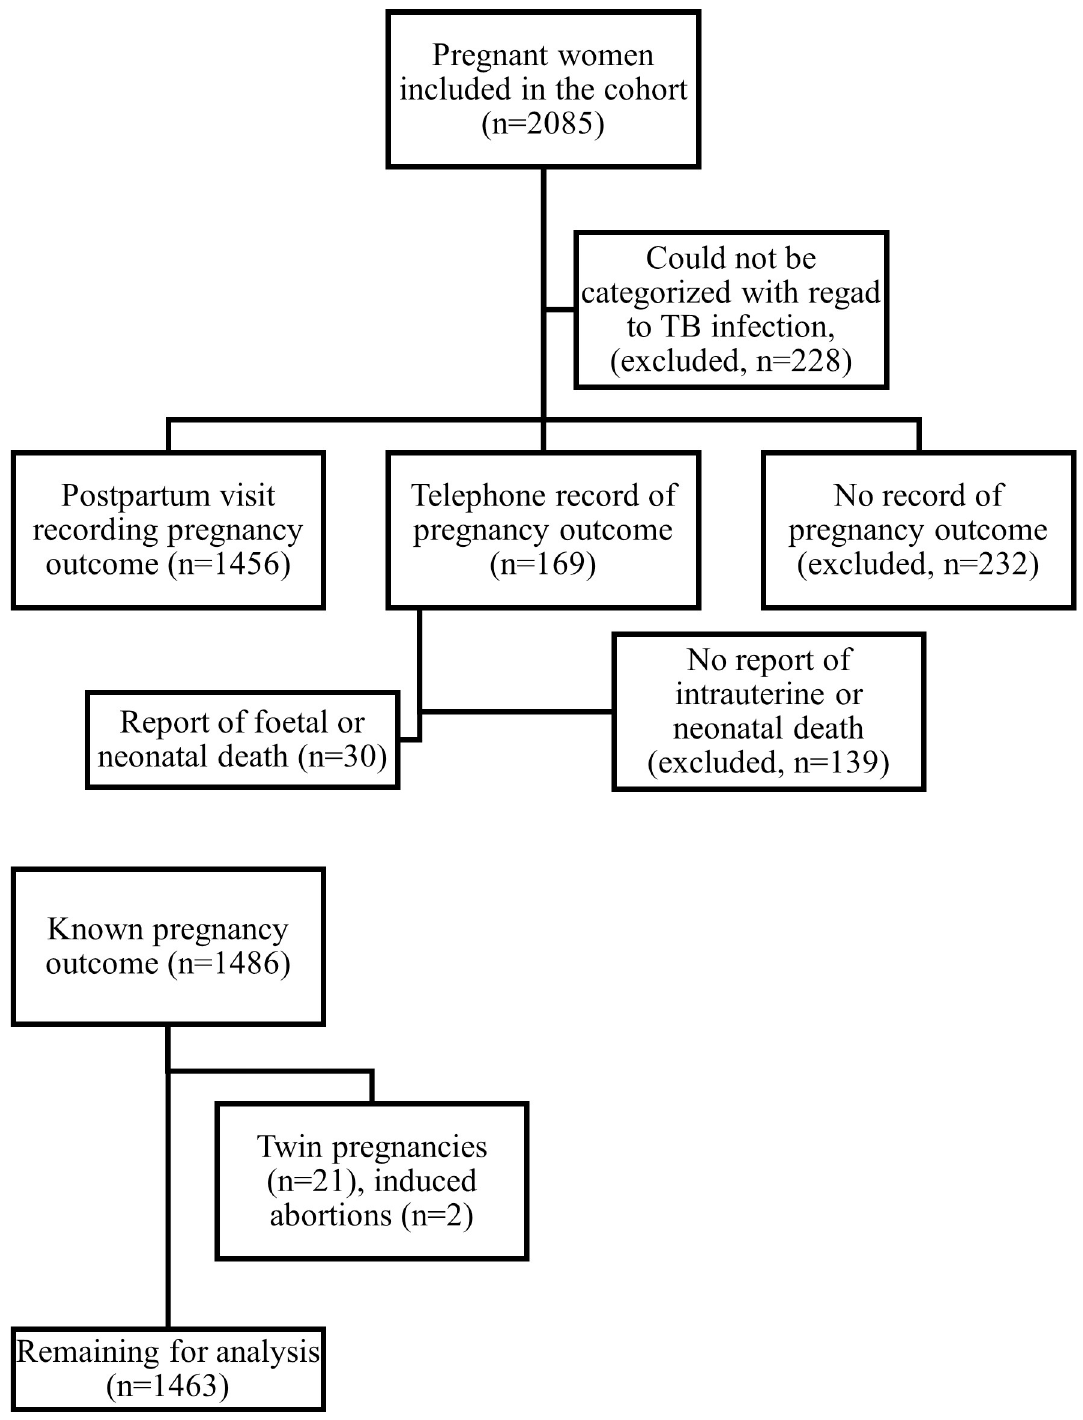
Fig 1. Flowchart of